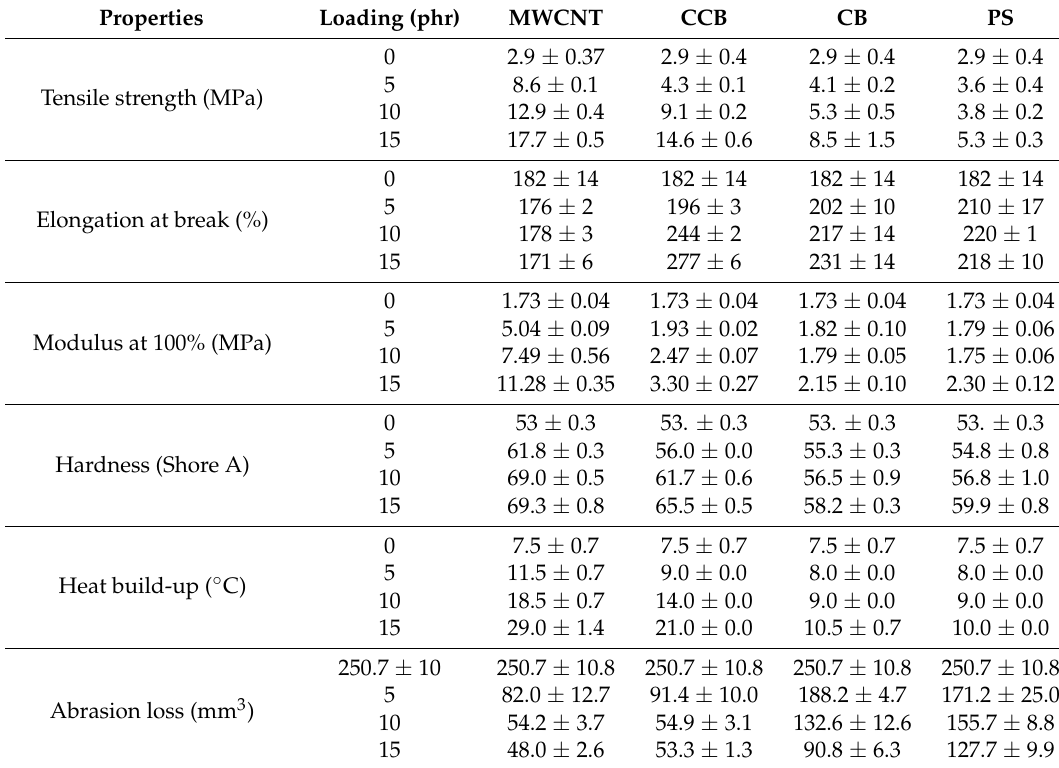
Table 8. Mechanical properties of acrylonitrile butadiene rubber (NBR) vulcanizates. Reproduced with permission from [97], Copyright Hindawi Publishing Corporation,